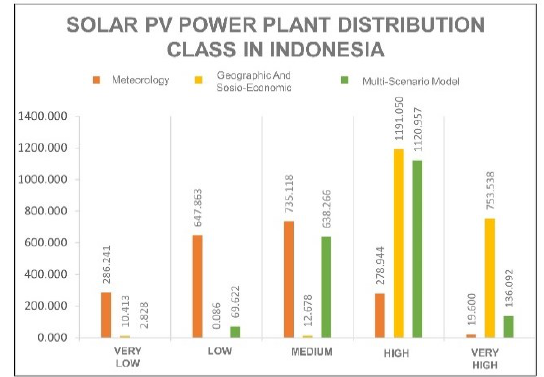
Figure 5 . Solar PV Power Plant Distribution Class in Indonesia